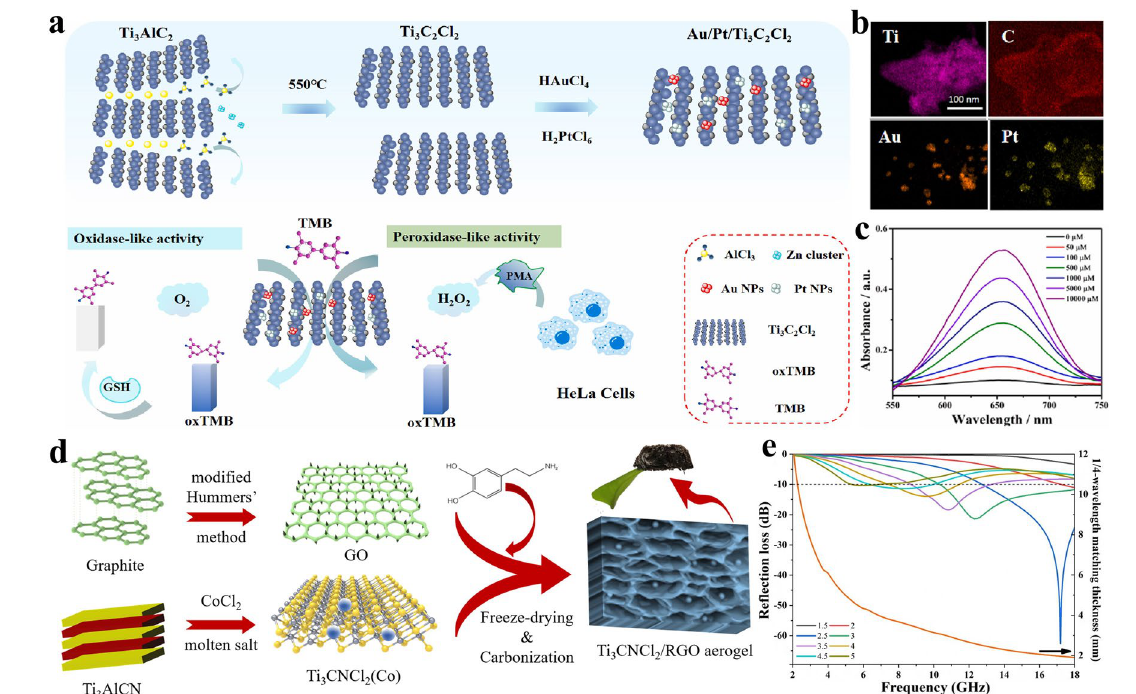
Fig. 17 a Schematic demonstrating the synthesis of Au/Pt/Ti 3 C 2 Cl 2 hybrids for in-situ detection of H 2 O 2 and colorimetric detection of glu- tathione. b EDS element mapping of Au/Pt/Ti 3 C 2 Cl 2 composites. c Absorption spectra of Au/Pt/Ti 3 C 2 Cl 2 nanocomposites system with increas- ing concentrations of H 2 O 2 . Reproduced with permission from [247] Copyright 2022, Elsevier. d Schematic representing the preparation of